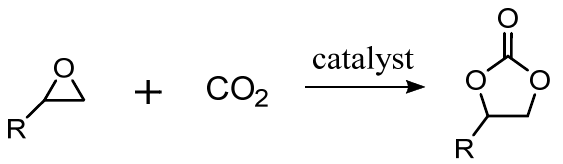
Figure 1. Imidazole and four of its derivatives.